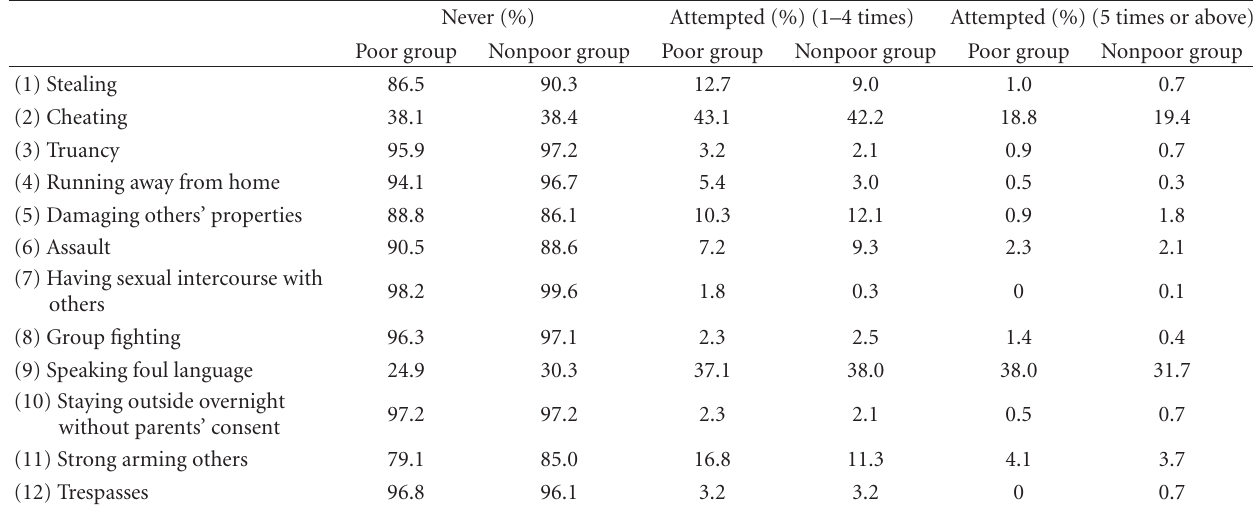
Table 3: Delinquent behaviors between poor and nonpoor groups in the past